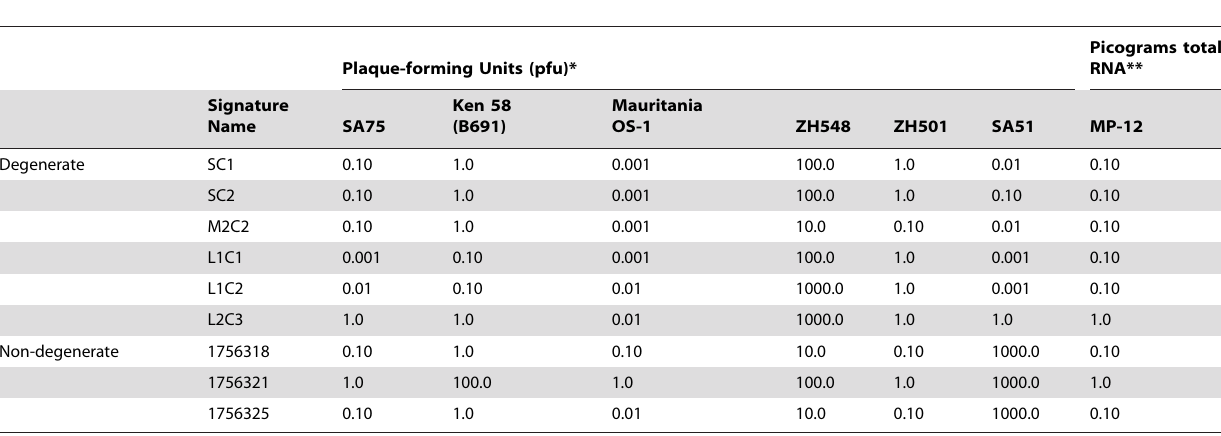
Table 7. Per Signature Limit of Detection for Rift Valley Fever Strains Tested: All tests were conducted on total nucleic acid extracts from clarified viral cultures containing the listed